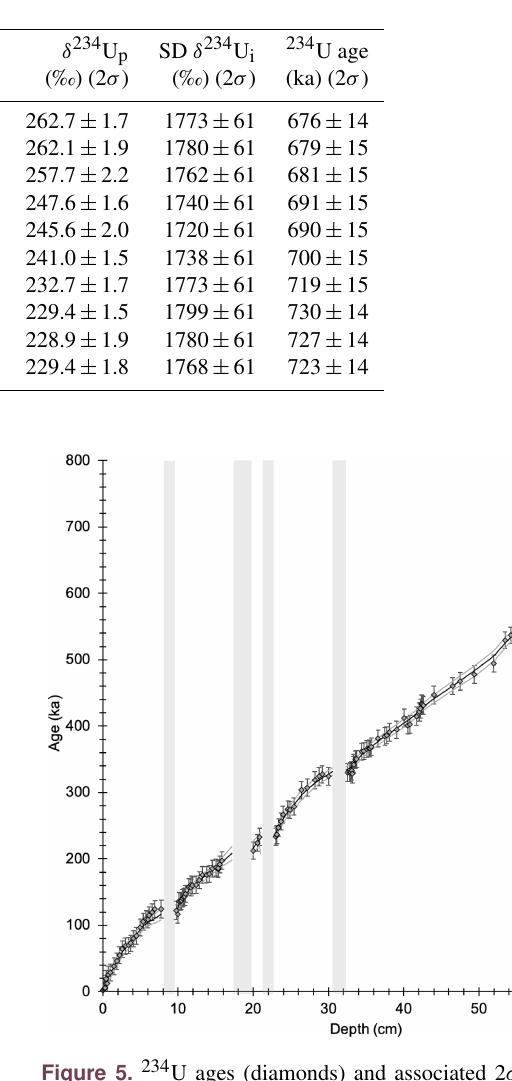
Figure 5. 234 U ages (diamonds) and associated 2 σ uncertainties along the length of the core penetrating the calcite crust. OxCal age model (black line) and 95% confidence limits (grey lines) were de- rived from 234 U ages. Locations of folia (grey bars) and a growth hiatus (dashed black line) are